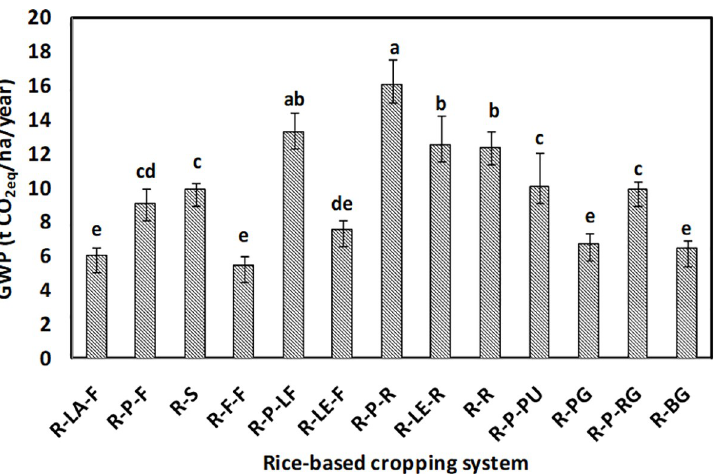
Fig 8. Global Warming Potential (GWP) of different rice-based cropping systems. [here, R-LA-F: rice-lathyrus- fallow, R-P-F: rice-potato-fallow, R-S: rice-sunflower, R-F-F: rice-fallow-fallow, R-P-LF: rice-potato-ladies finger, R-LE-F: rice-lentil-fallow, R-P-R: rice-potato-rice, R-LE-R: rice-lentil-rice, R-R: rice-rice, R-P-PU: rice-potato- pumpkin, R-PG: rice-pointed gourd, R-P-RG: rice-potato-ridge gourd, R-BG: rice-bitter gourd].